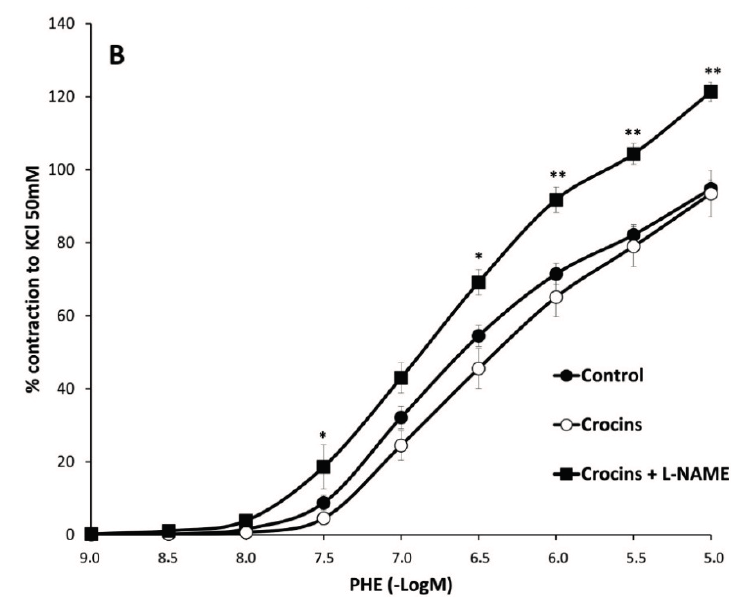
Figure 4. Effects of L-NAME on the responses of crocetin (CCT) (panel A ) and crocins (panel B ) -preincubated aortic segments to increasing concentrations of phenylephrine.